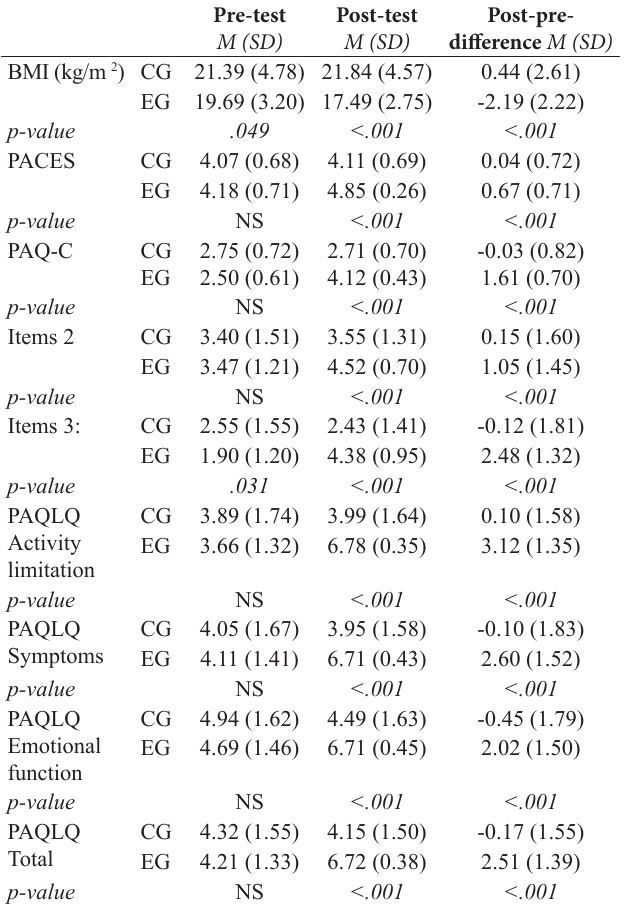
Table 1. Anthropometric variables, enjoyment of physical activity questionnaire (PACES), physical activity questionnaire (PAQ-C), quality of life of paediatric asthma questionnaire